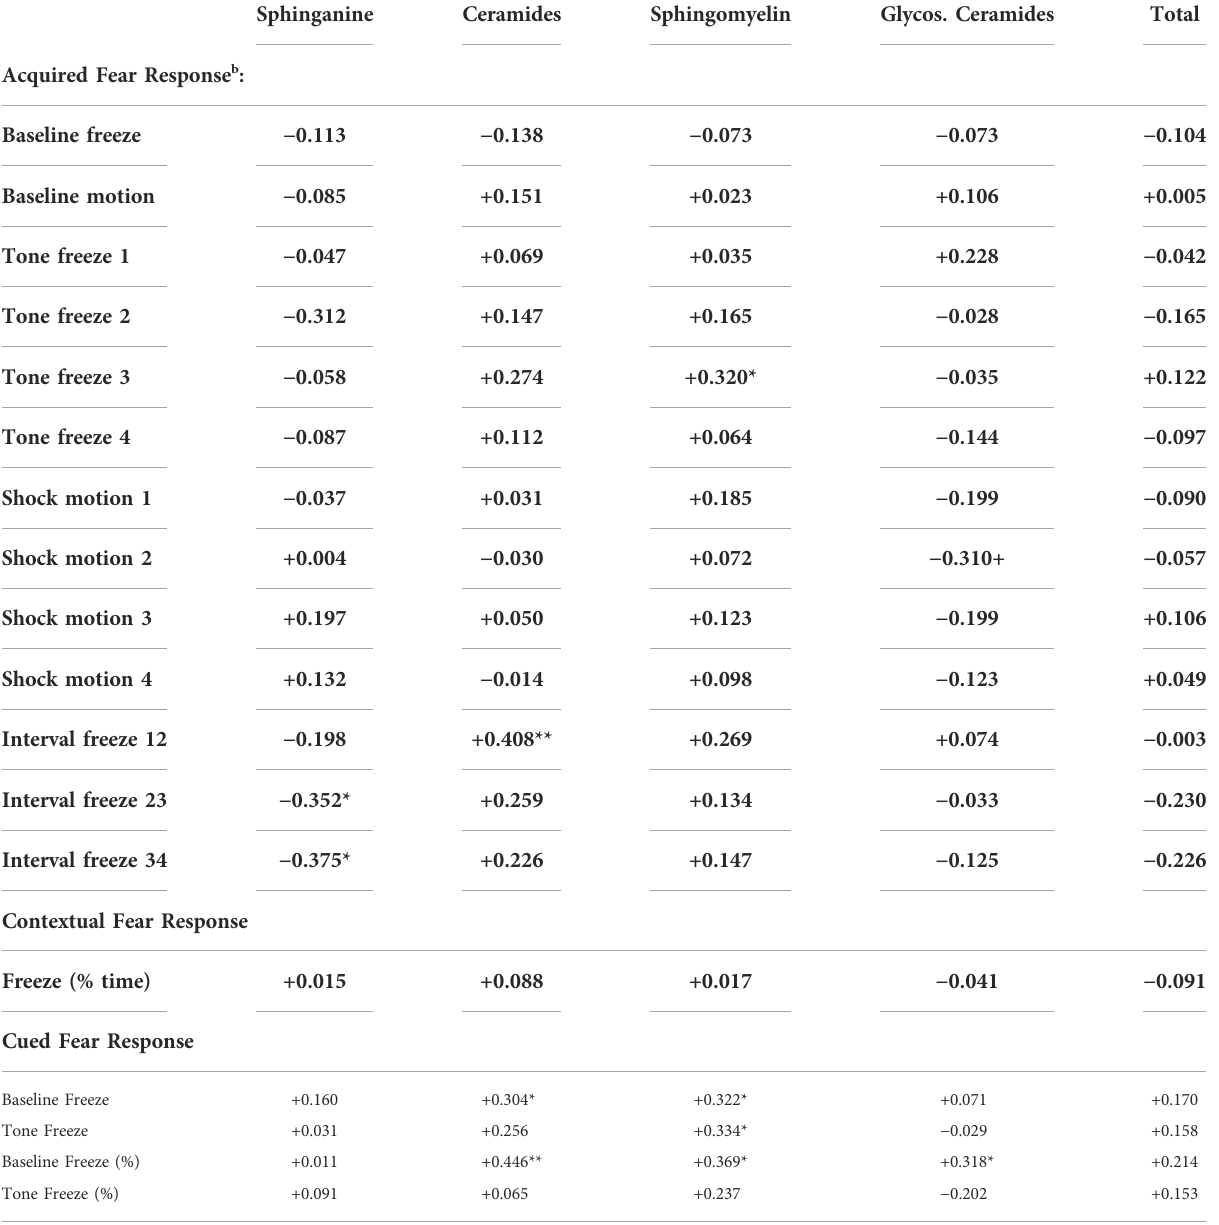
TABLE 3 Association (Spearman correlations) between fear conditioning (1 – 4 refers to trial number) and sphingolipid group levels in the standard exposure experiment a